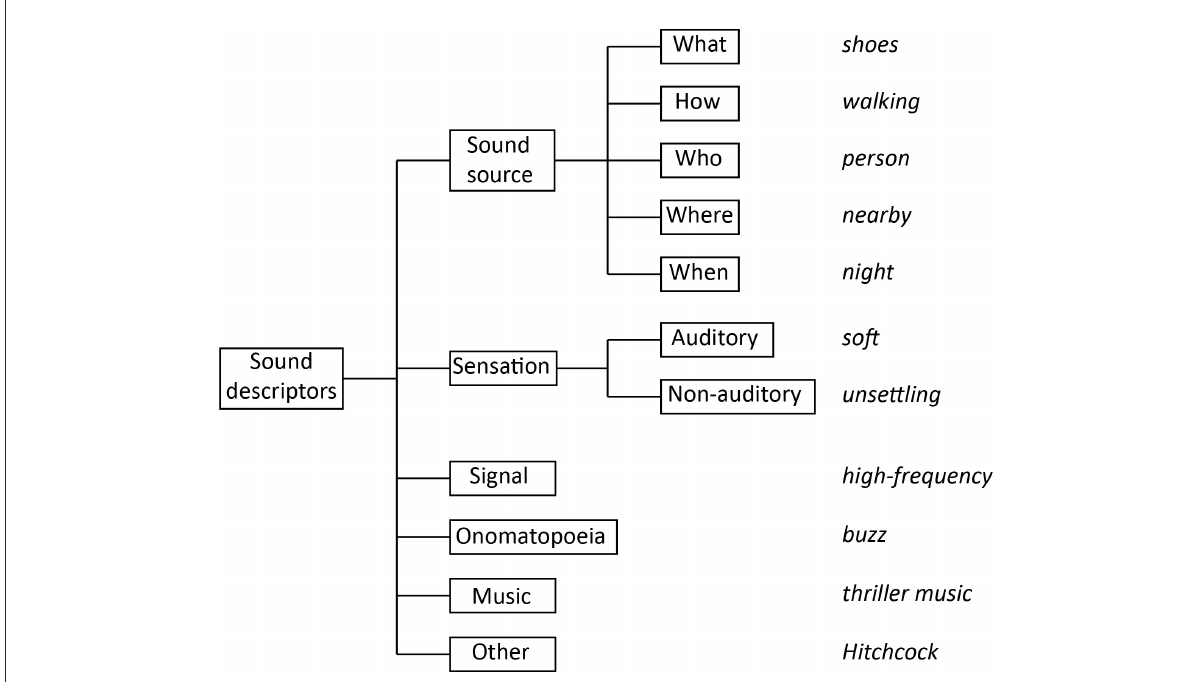
FIGURE1 Hierarchy of sound-descriptor categories considered to characterize the semantics of the surveyed taxonomies and ontologies of everyday sounds (examples in